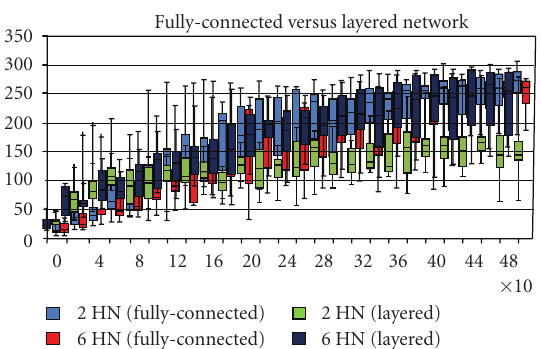
Figure 9: Box-and-whisker diagram of the repeated evaluation of fully connected versus layered ANN with cartesian